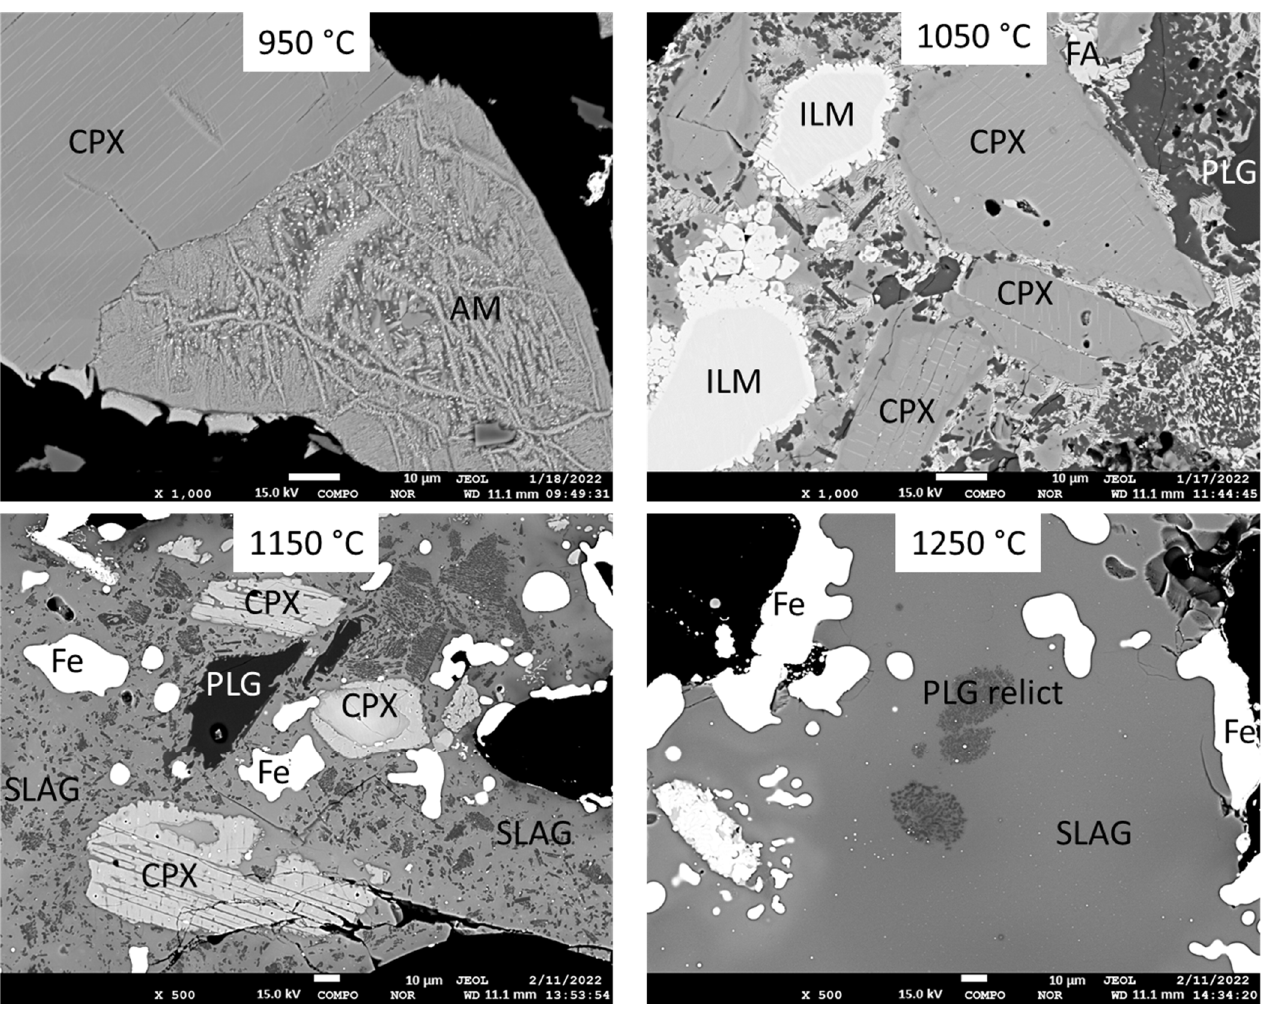
Figure 11. Details of mineral reactions and progression of decomposition with formation of slag and metallic iron at 950, 1050, 1150, and 1250 °C. Mineral abbreviations: CPX = clinopyroxene, AM = and metallic iron at 950, 1050, 1150, and 1250 ◦ C. Mineral abbreviations: CPX = clinopyroxene, amphibole, ILM = ilmenite, FA = fayalite, PLG = plagioclase, Fe = metallic iron. AM = amphibole, ILM = ilmenite, FA = fayalite, PLG = plagioclase, Fe = metallic